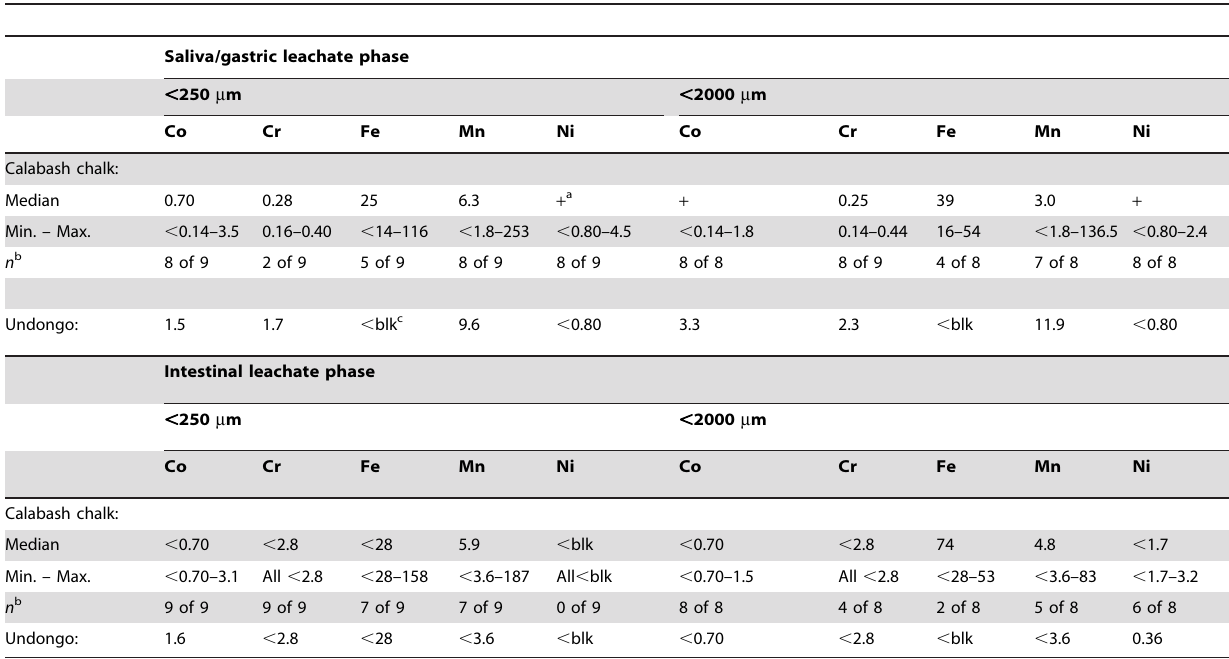
Table 5. Bioaccessible concentrations (mg/kg) associated with the F-SNF saliva/gastric and intestinal phases of the in vitro